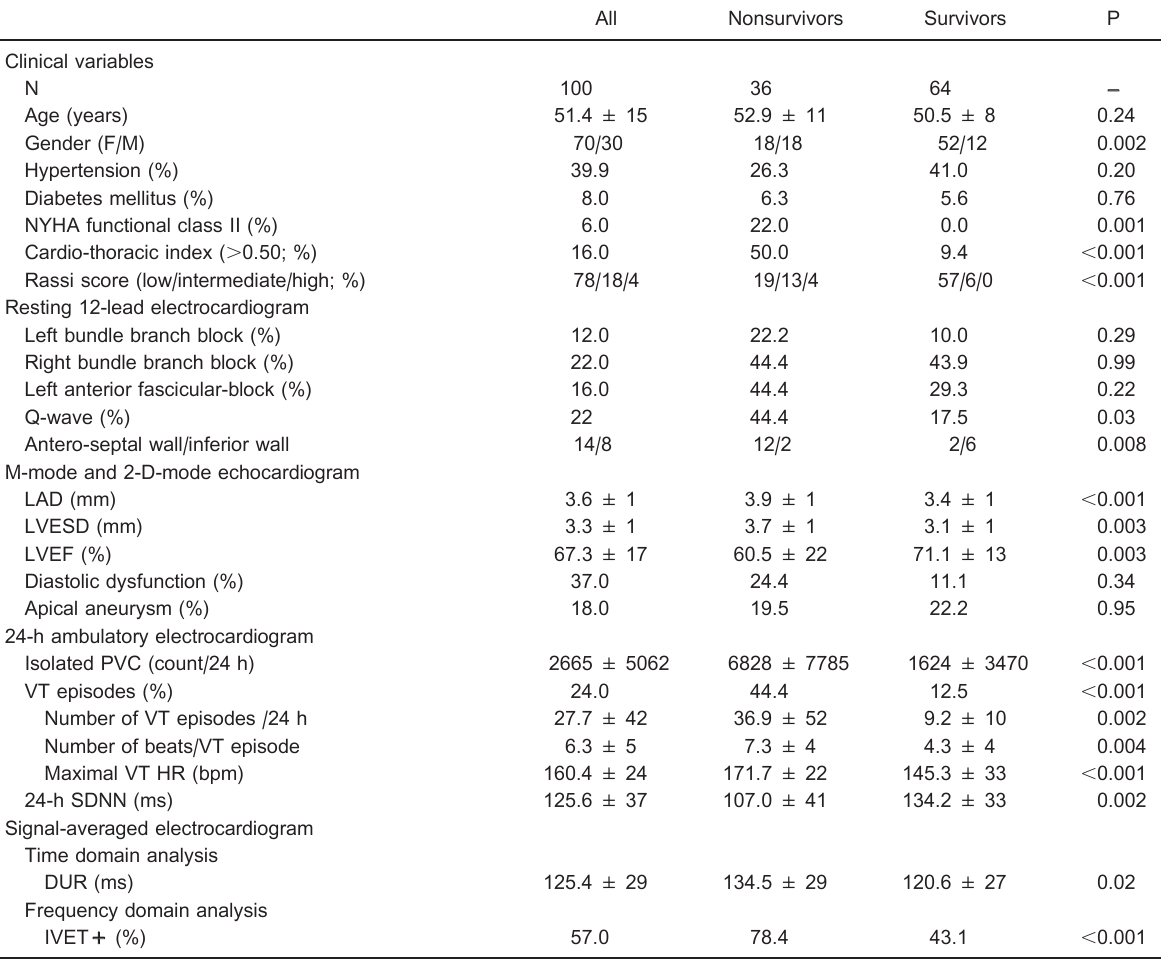
Table 1. Clinical, electrocardiographic, and echocardiographic variables determined on admission as a function of clinical outcome during